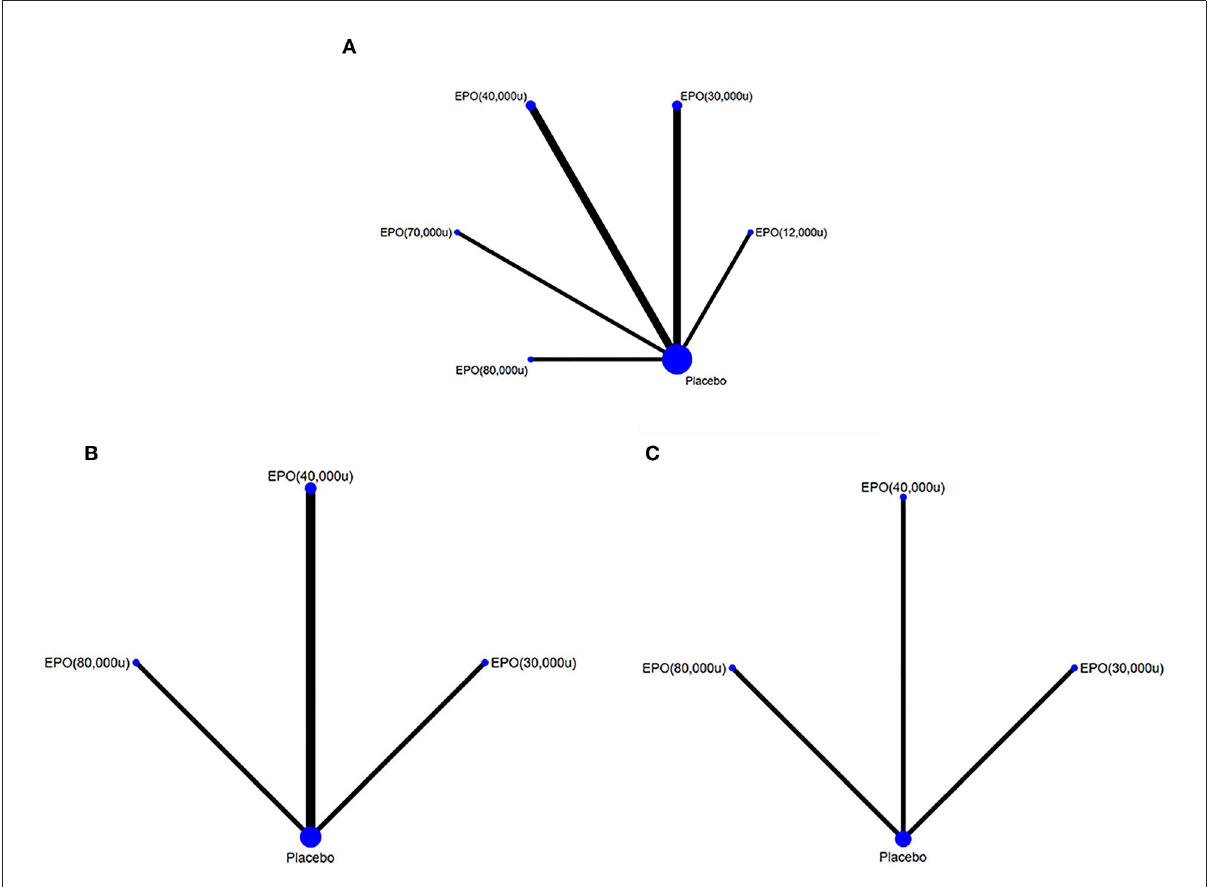
FIGURE4 Network comparison plots for outcome indicators. (A) mortality, (B) deep vein thrombosis, and (C) pulmonary embolism. EPO, erythropoietin; u,